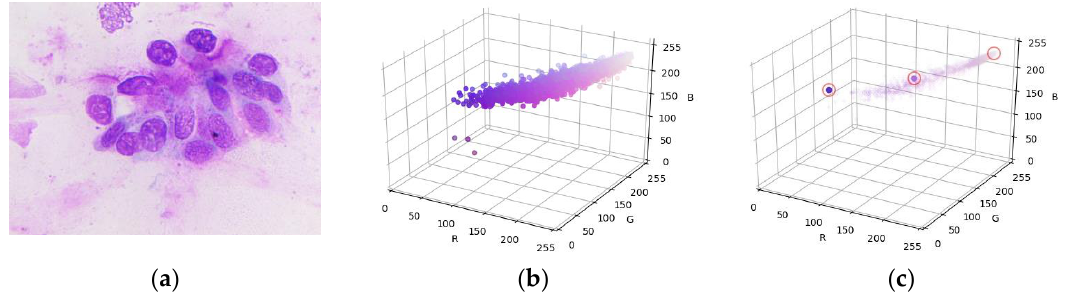
Figure 4. A cell field ( a ), surface construction ( b ), and cluster detection ( c ).